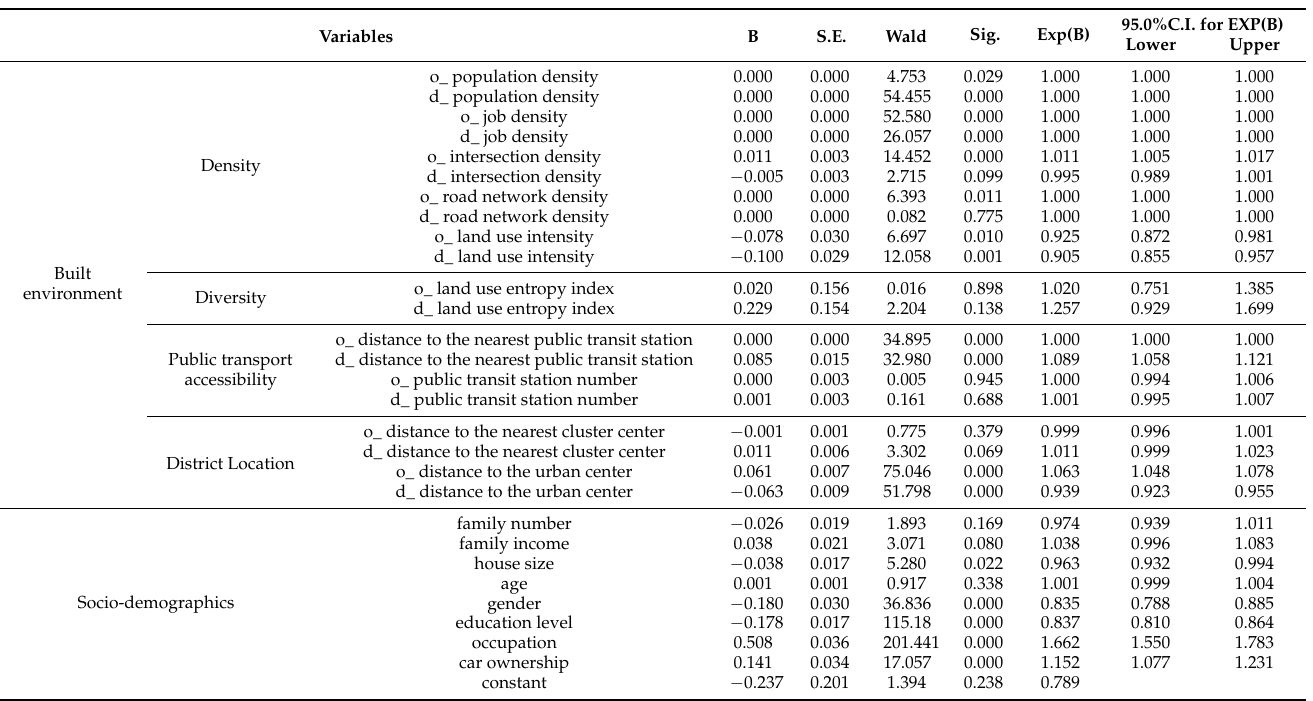
Table A2. Logistic regression results of